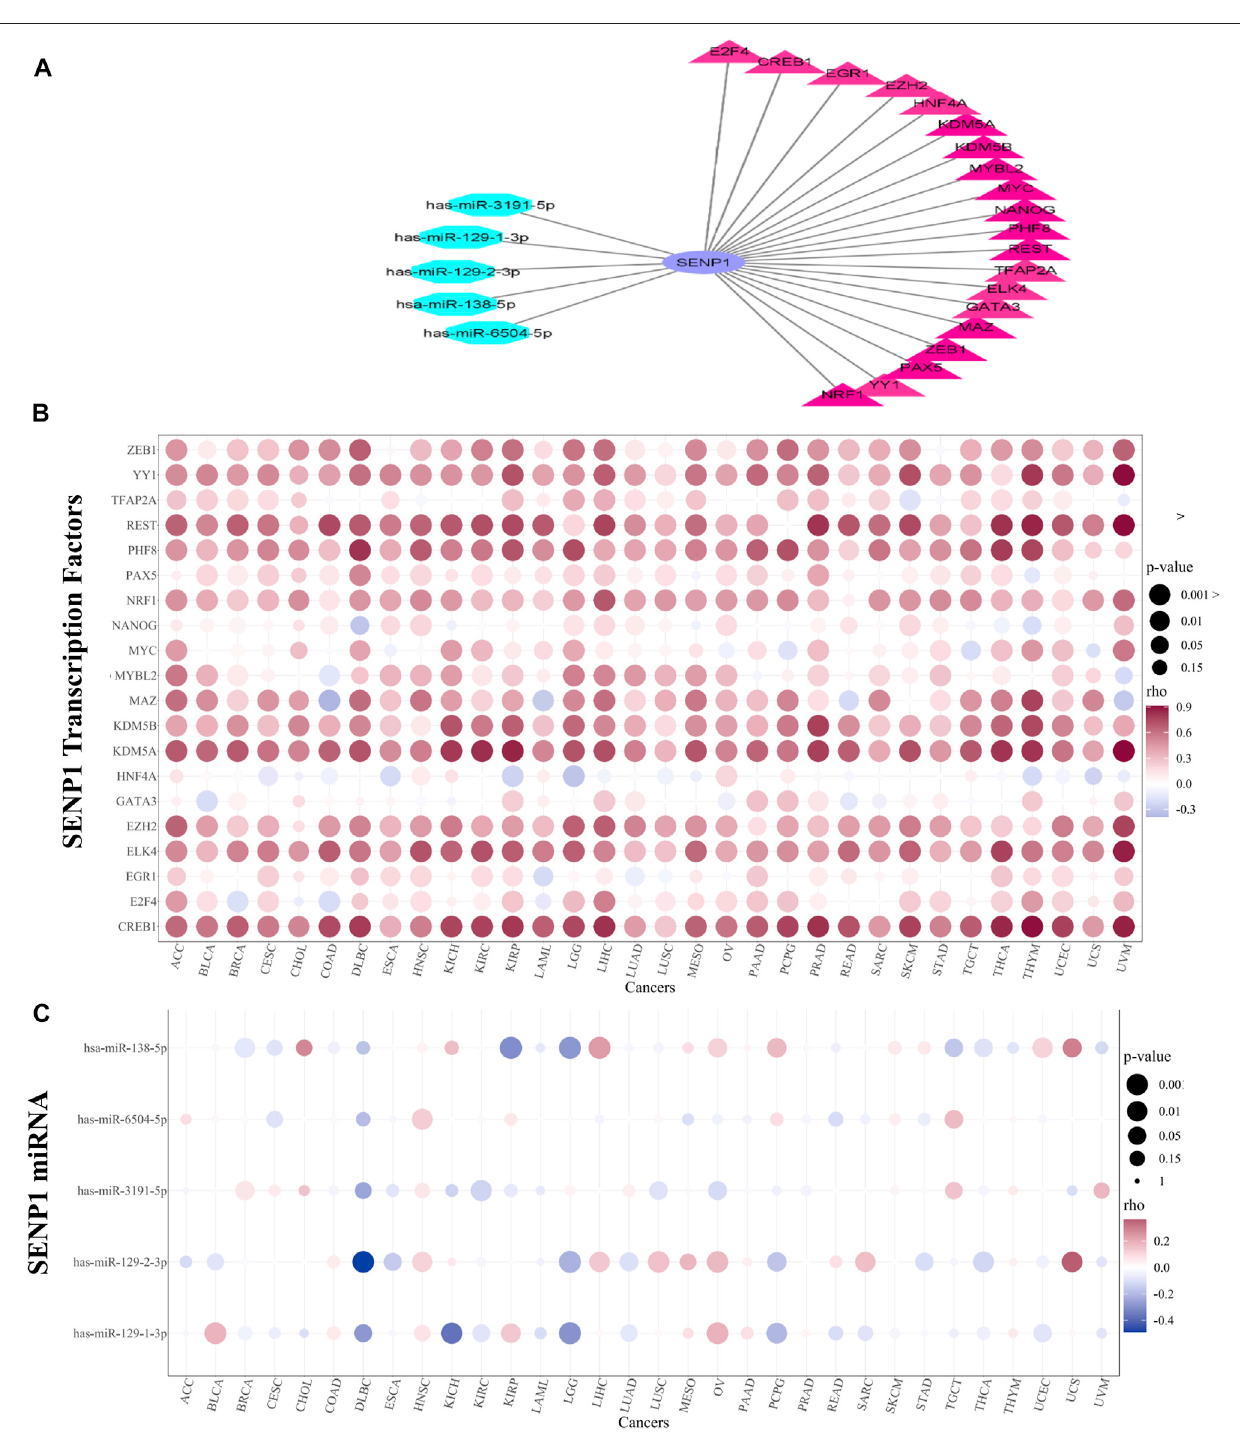
Frontiers in Pharmacology |